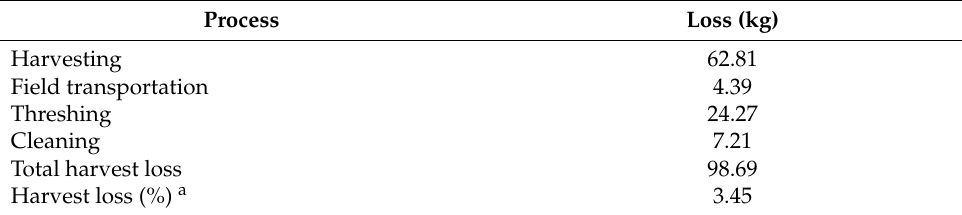
Table 2. Descriptive statistics on rice harvest